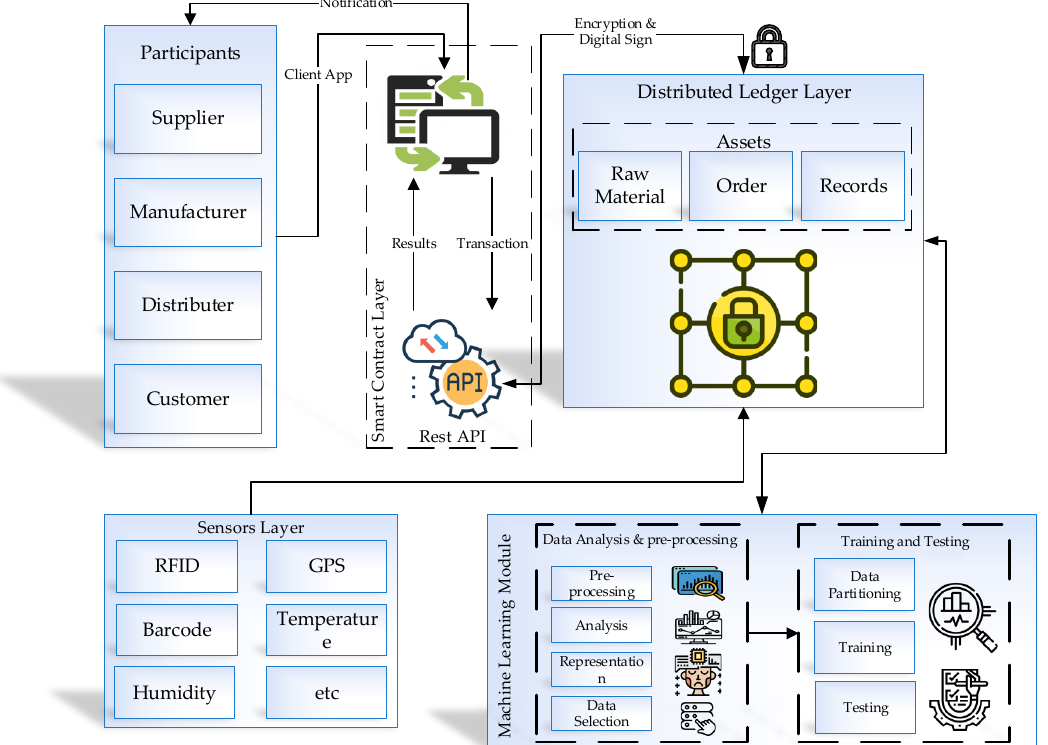
Figure 2. System architecture